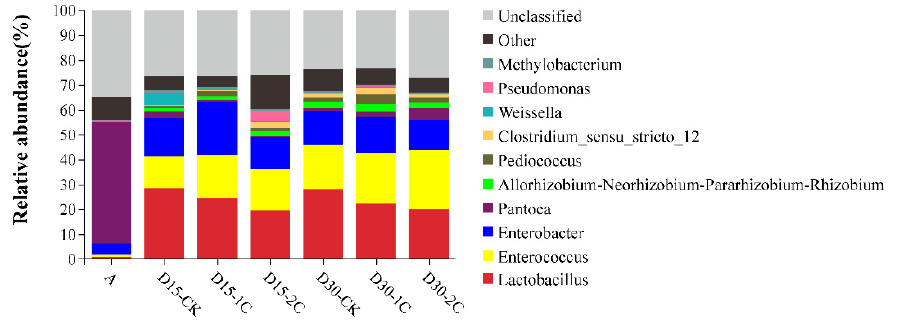
Figure 2. Microbial community and relative abundance by genus for alfalfa silage (A, fresh alfalfa; CK, the control; 1C, 1% biochar; 2C, 2% biochar; D15, D30, after 15, 30 days ensiling, respectively).